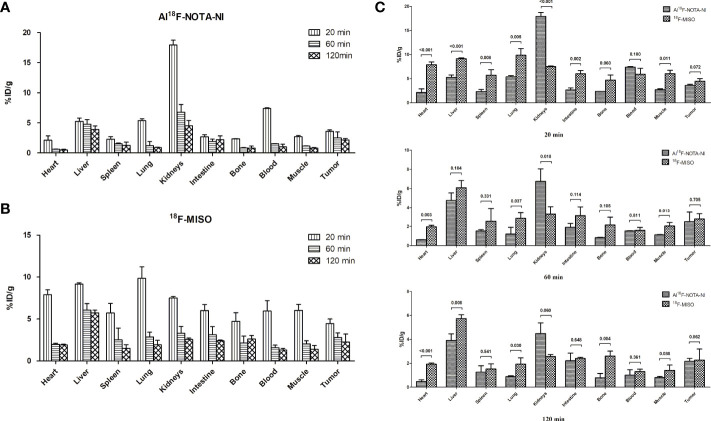

(A) Percentages of injected dose per gram of tissue (%ID/g ± SD) in major organs of xenografted mice at 20, 60, and 120 min p.i. for Al18F-NOTA-NI (n = 3 per time point). (B) Percentages of injected dose per gram of tissue (%ID/g ± SD) in major organs of xenografted mice at 20, 60, and 120 min p.i. for Al18F-NOTA-NI (n = 3 per time point). (C) Uptake value (%ID/g ± SD) of Al18F-NOTA-NI in comparison with that of 18F-MISO in the same kind of organ at 20, 60, and 120 min p.i (n = 3 per time point).